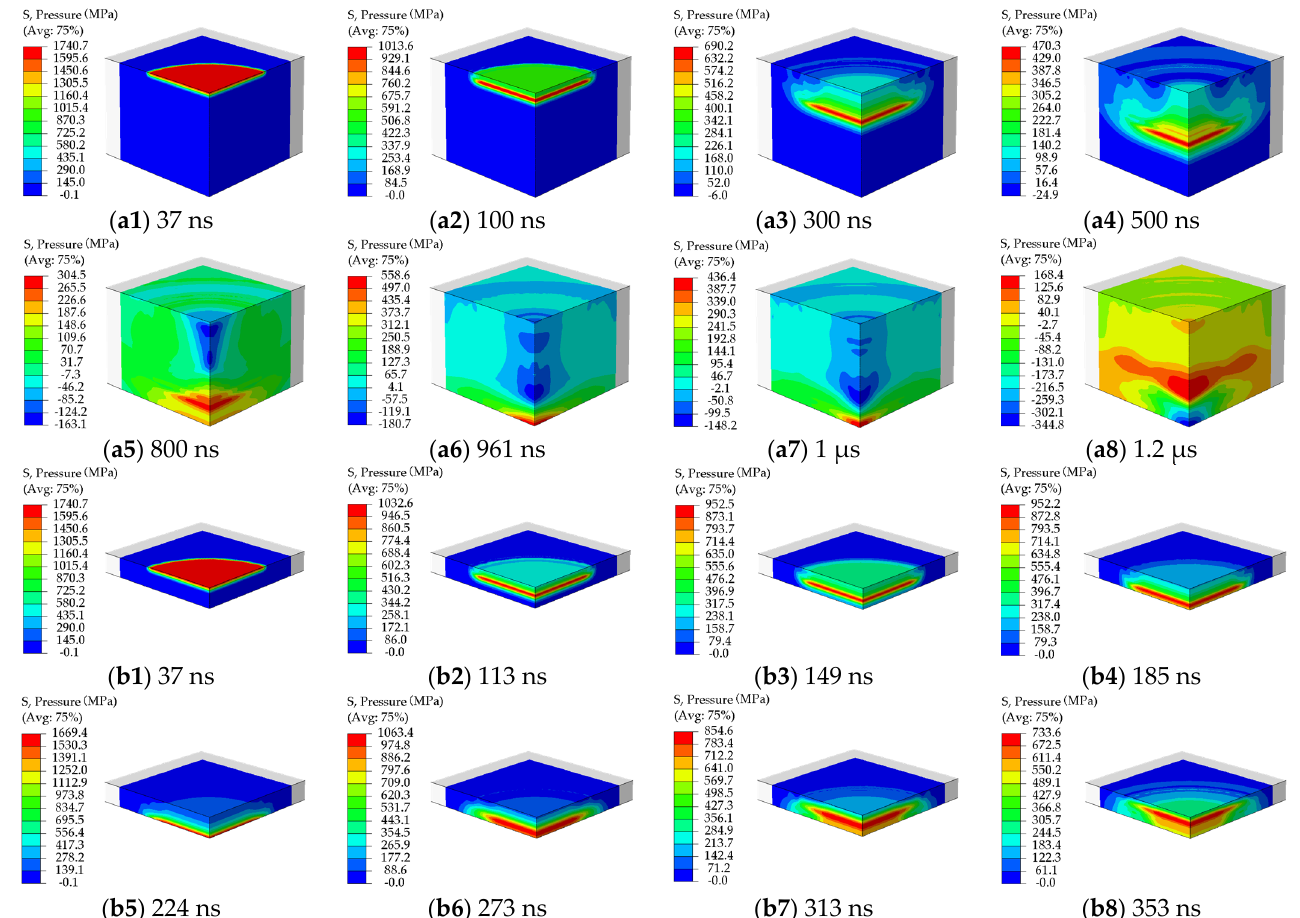
Figure 8. LSP − induced shock waves propagating in the target models: ( a ) 5 mm − thickness target Figure 8. LSP-induced shock waves propagating in the target models: ( a1 – a8 ) 5 mm-thickness target model; ( b ) 1 mm − thickness target model. model; ( b1 – b8 ) 1 mm-thickness target model.